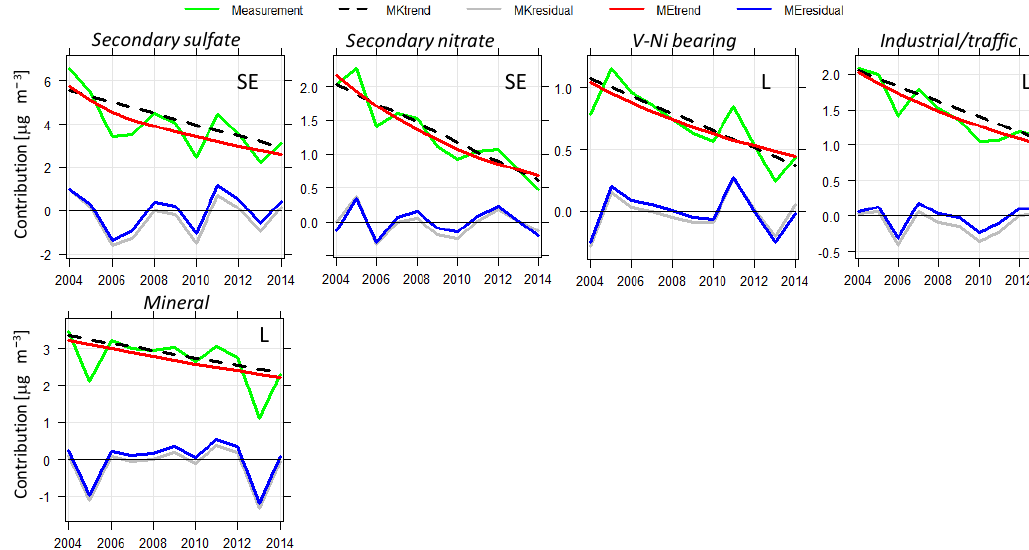
Figure 7. Mann–Kendall and multi-exponential trends for source contributions in PM 10 at MSY. Measured concentration (green line); multi- exponential trend (red line); multi-exponential residuals (blue line); Mann–Kendall trend (black line); Mann–Kendall residuals (gray line). Trend type: linear (L), single exponential (SE), double exponential